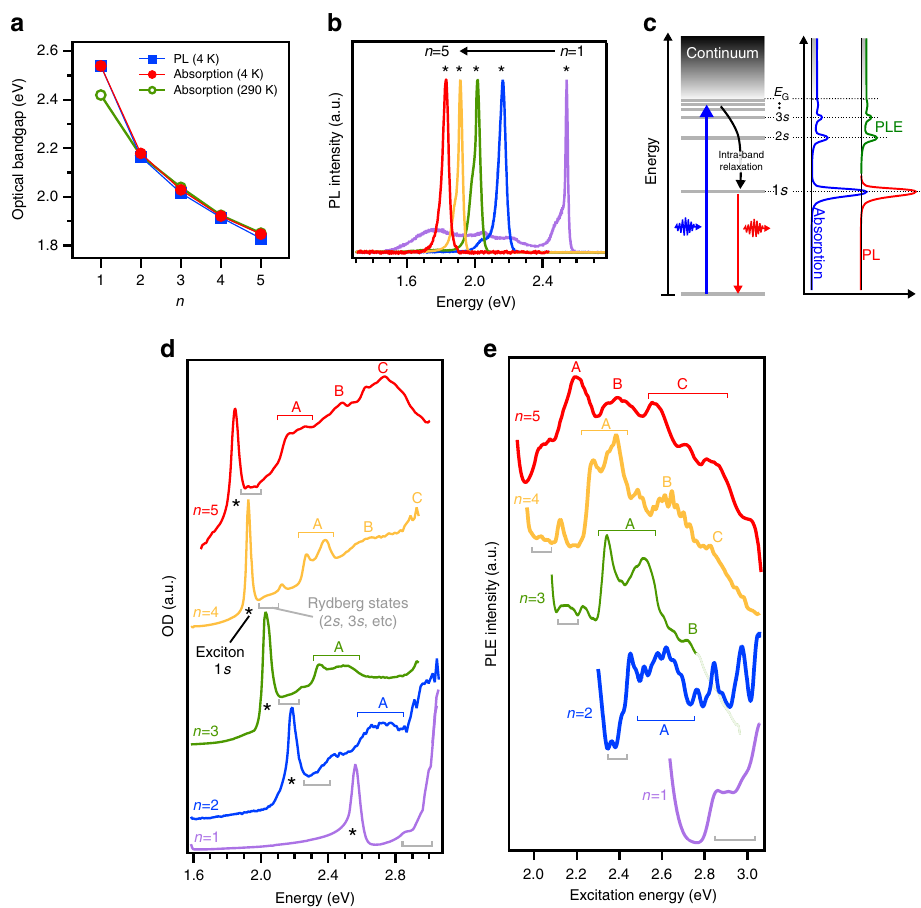
Fig. 3 Optical spectroscopy of the RPP crystals with n equals 1 to 5. a Experimental optical bandgap scaling. b Photoluminescence spectra. c Schematics of the Rydberg series of the exciton ground state (1 s ) and excited exciton states (2 s , 3 s , etc.) merging with the continuum. (Right) Corresponding absorption or optical density, photoluminescence PL, and photoluminescence excitation PLE spectra typically observed in 2D material systems 26,49 . d Optical density OD and e PLE spectra of the RPPs with n equals 1 to 5, respectively. Stars point to exciton ground state optical transitions, black squares show the continuum onsets and gray brackets indicate the region of excited exciton states. Labels A, B and C indicate absorption regions at energies higher than the continuum bandgap E G and which are apparently common to all the RPPs given an energy shift proportional to the